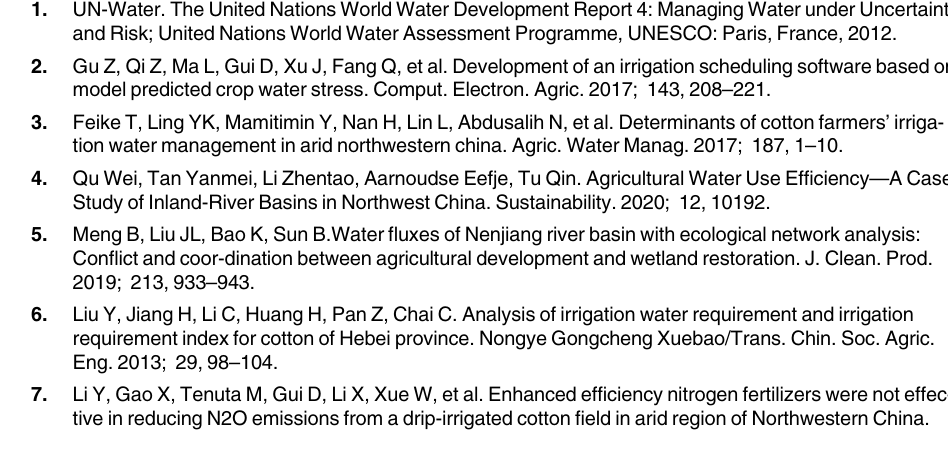
S1 Fig. Field pictures of the experimental